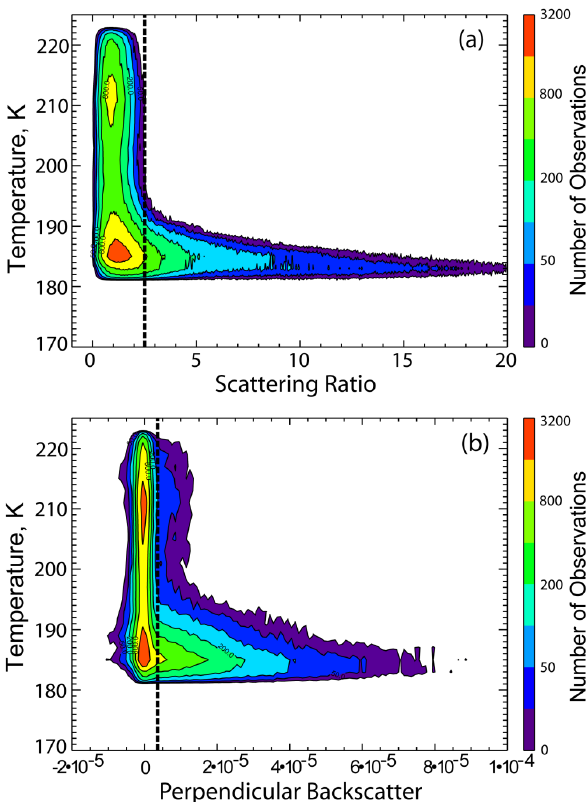
Fig. 1. Ensemble of (a) 532-nm scattering ratio and (b) 532-nm per- Figure 1. Ensemble of (a) 532-nm scattering ratio and (b) 532-nm perpendicular pendicular backscatter measurements as a function of observed tem- perature for the 400–500K potential temperature layer from an indi- backscatter measurements as a function of observed temperature for the 400–500 K vidual orbit of CALIPSO data on 1 August 2006. The black dashed potential temperature layer from an individual orbit of CALIPSO data on 1 August lines indicate the scattering ratio and perpendicular backscatter co- 2006. The black dashed lines indicate the scattering ratio and perpendicular backscatter efficient thresholds for PSC coefficient thresholds for PSC detection.